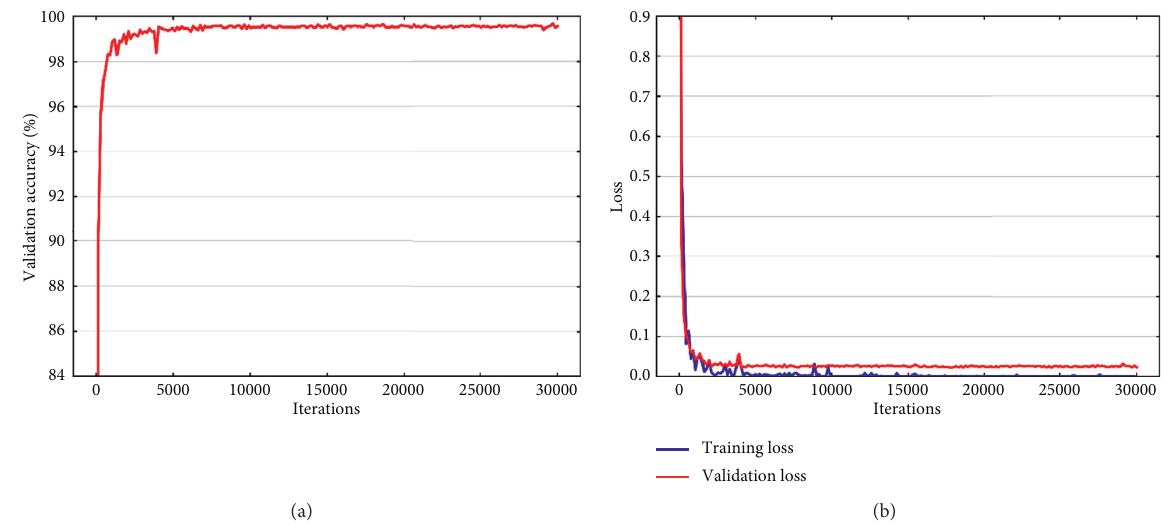
Figure 11: Validation accuracy, training loss, and validation loss results. (a) Validation accuracy and (b) training loss and validation loss.